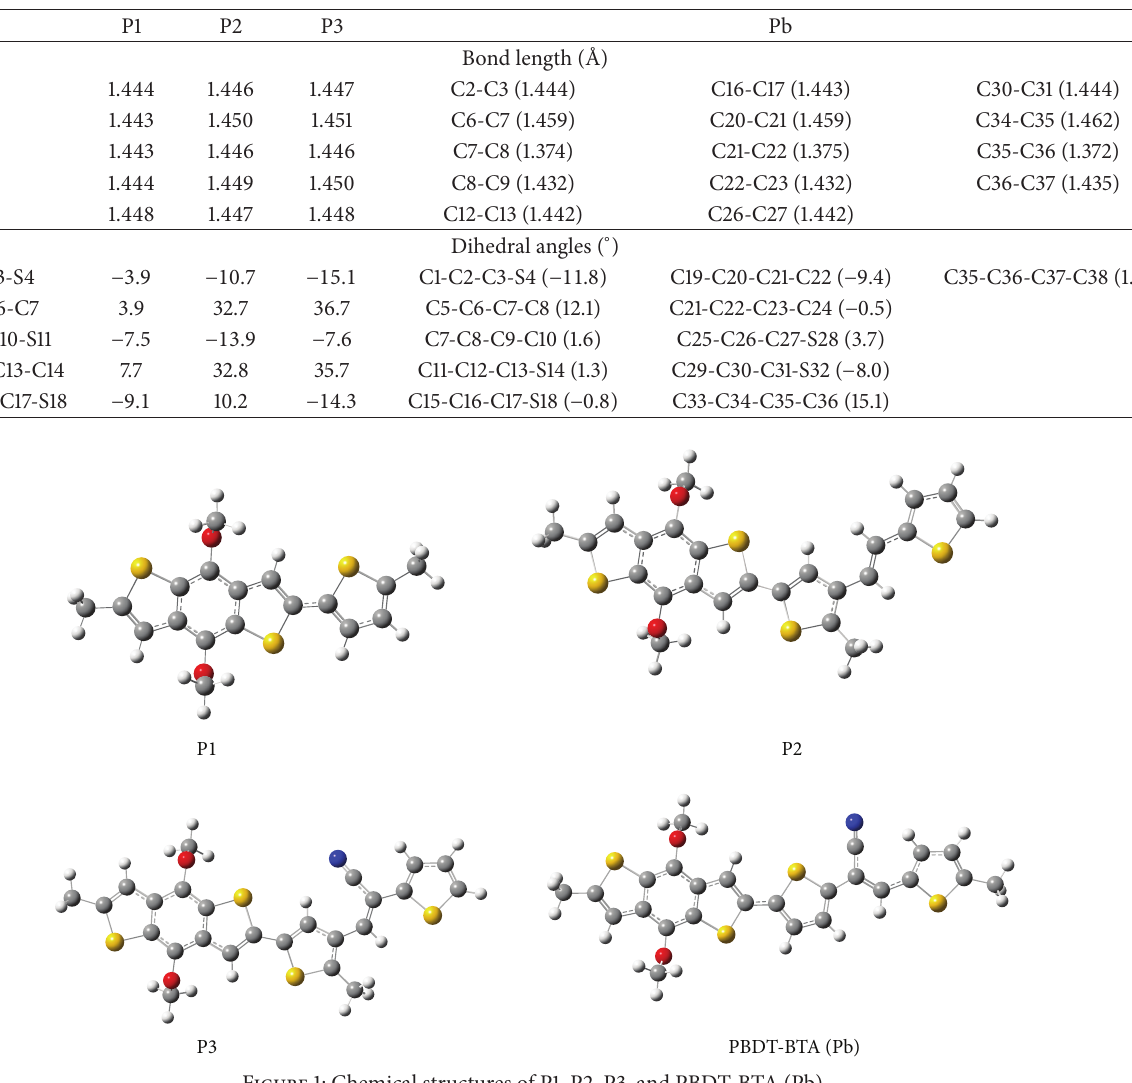
Table 1: Selected optimized bond length and dihedral angles of P1, P2, P3, and PBDT-BTA (Pb) for unit 𝑛 = 3 .